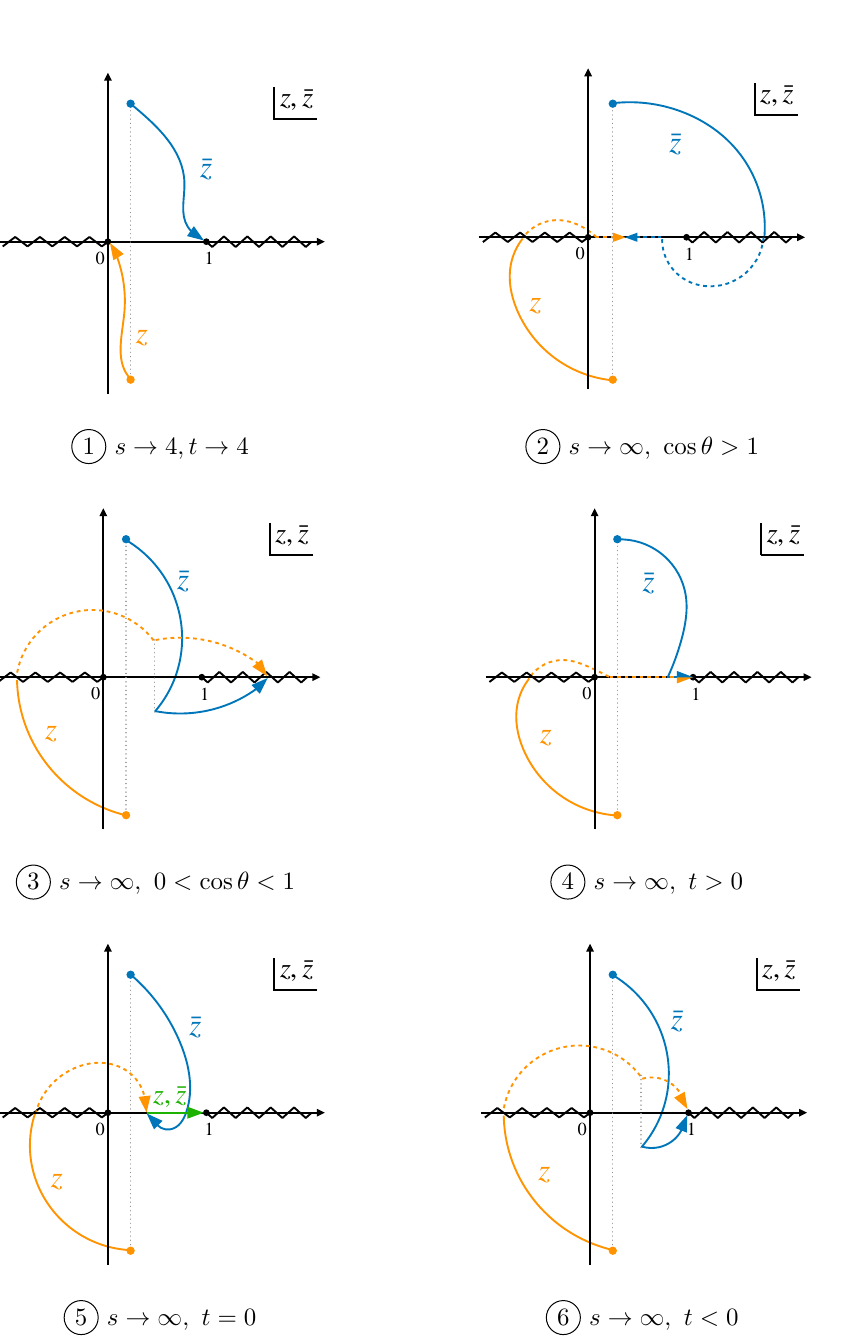
Figure 21. Different kinematic limits in z, ¯ z . The dashed curves indicate that the cross ratios are in the second sheet. The grey dotted lines indicate that z and ¯ z are complex conjugate of each